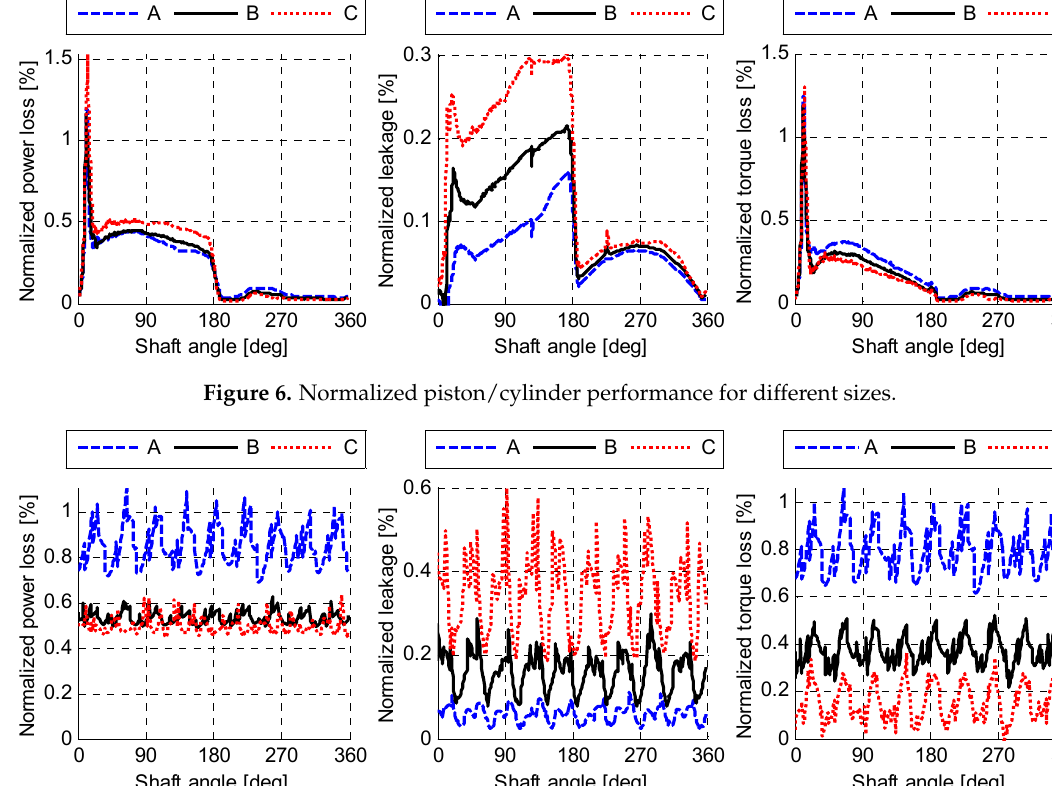
Figure 7. Normalized cylinder block/valve plate interface performance for different sizes.